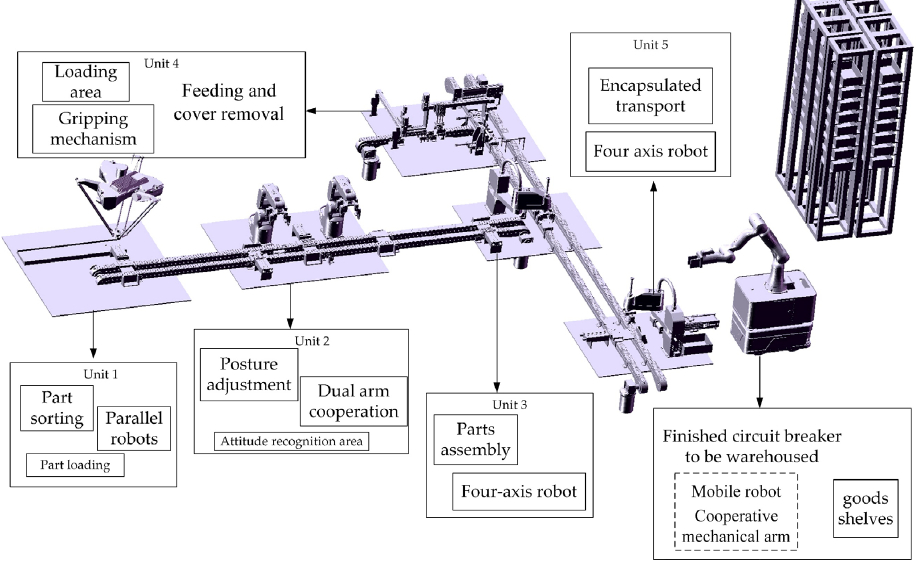
Figure 4. The construction of the multi-robot collaborative CBs flexible manufacturing system.